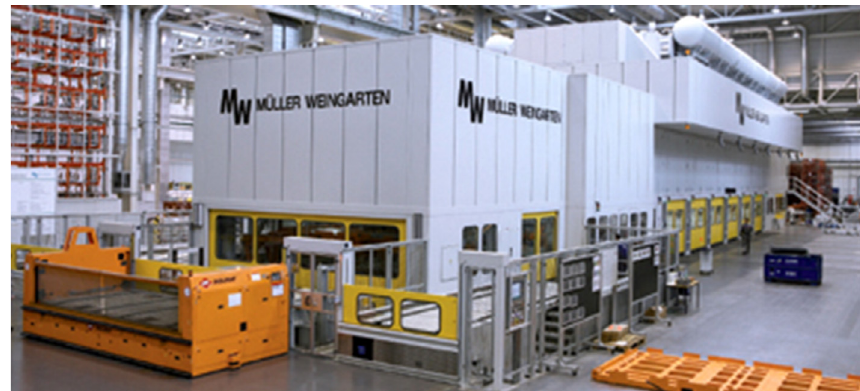
Figure 2. High volume ‘‘Compact’’ Automotive crossbar press (Schuler Automation)